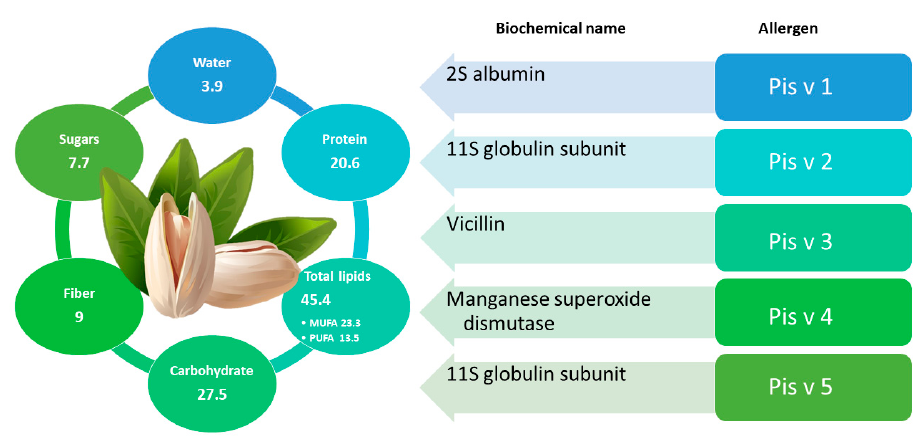
Figure 5. ( Left ) relevant information on the nutritional composition (g/100 g) relating to the Pistacia vera species. ( Right ) list of allergenic proteins identified and registered to date on the WHO/IUIS online allergen platform.